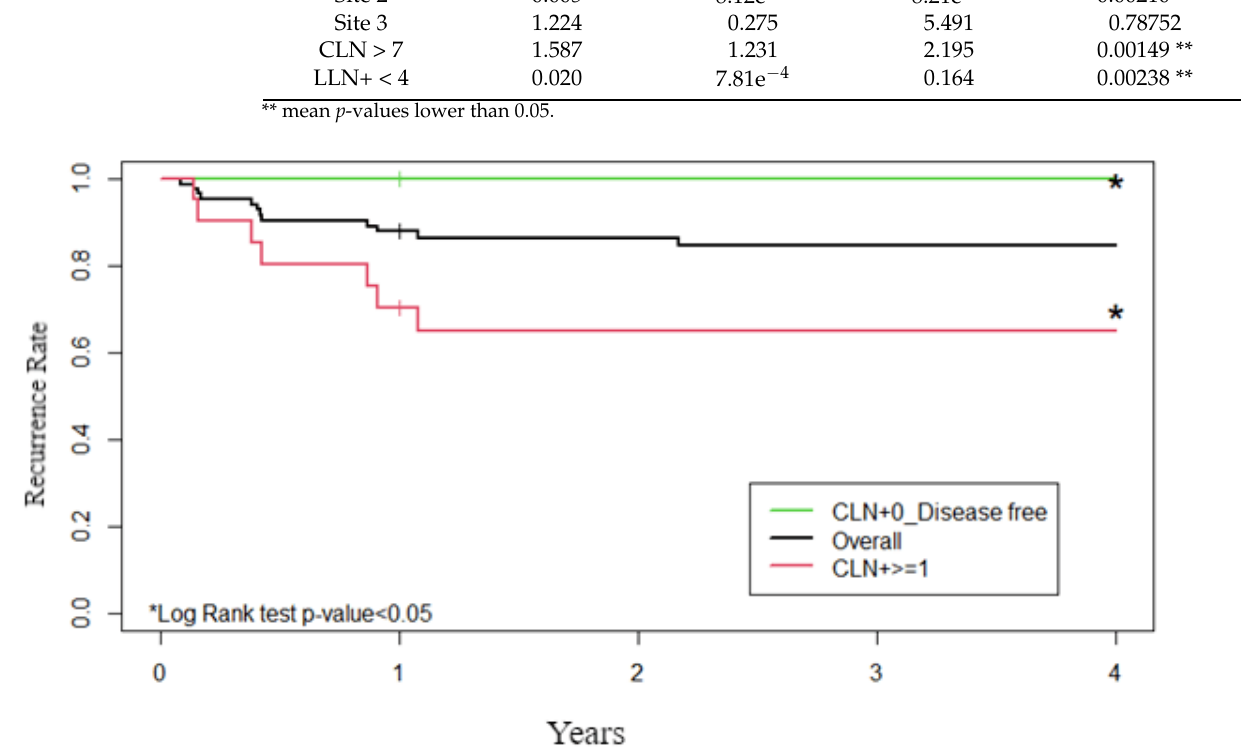
Figure 2. The group of patients with no central lymph nodes involvement has longer disease-free survival than the group with metastatic central lymph nodes ( p < 0.05). Kaplan–Meier Curves.